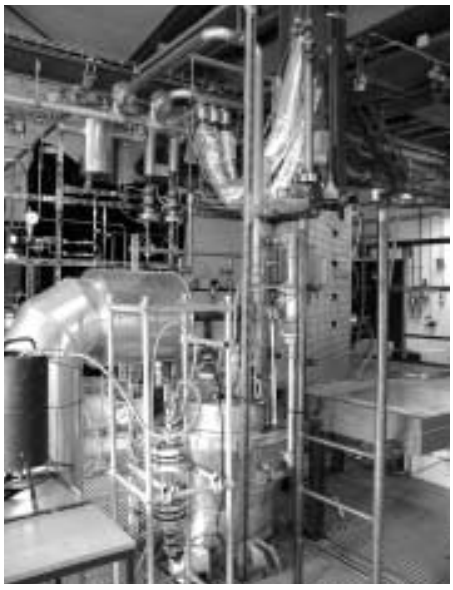
Fig. 5 Low-Pressure Flame Reactor.